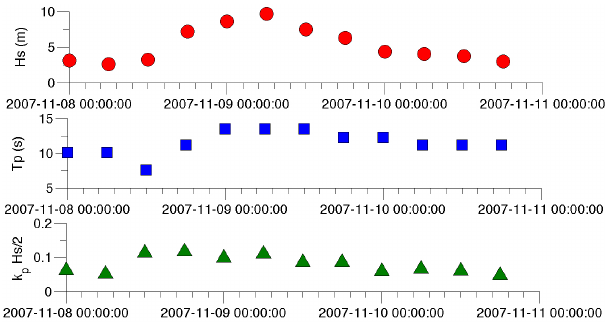
Figure 2. History of significant wave height, spectral wave period and sea state steepness for the total sea during the Andrea